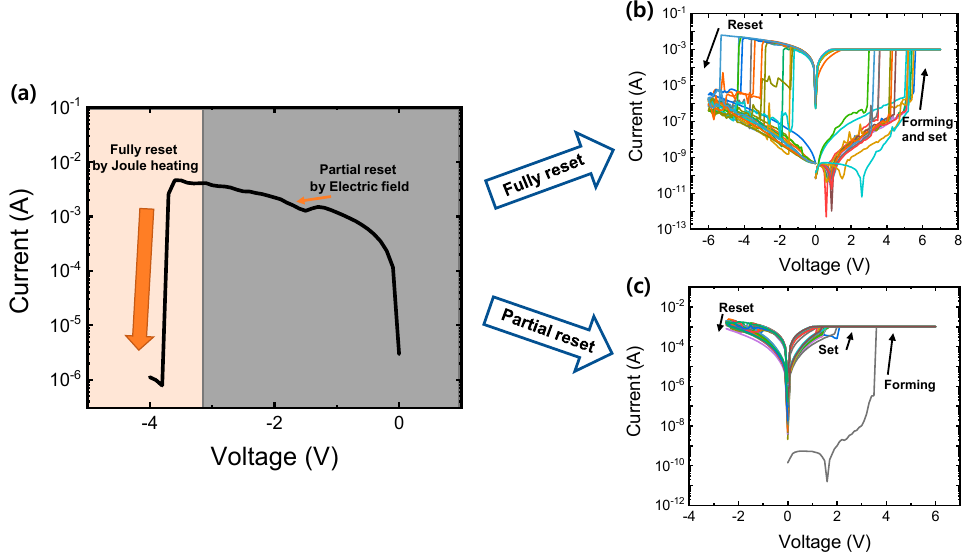
Figure 2. ( a ) Switching decision by reset voltage amplitude. I-V curves by ( b ) full reset mode and ( c ) partial reset mode.